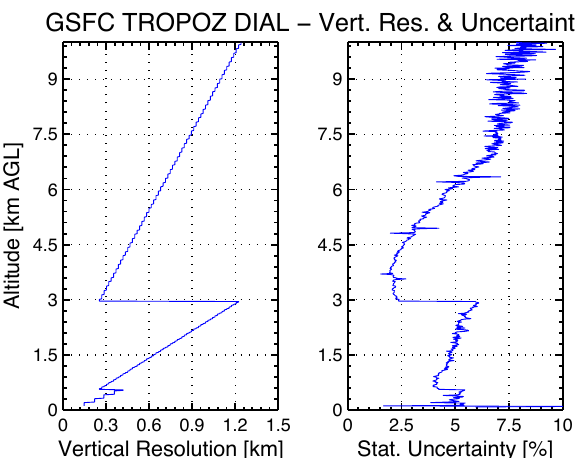
Figure 7. The left panel shows the associated vertical resolution in the TROPOZ opt retrieval algorithm, which is derived from the win- dow size of the SG differentiation filter. The right panel shows the statistical uncertainty in the system associated with these vertical resolutions, which is an approximation for the overall uncertainty for the TROPOZ opt